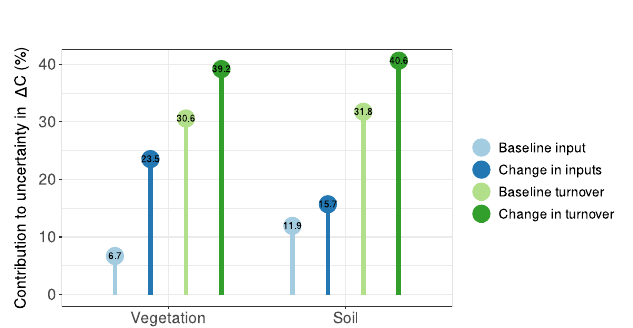
Fig. 5 | Attribution of uncertainty to processes in modelled changes in carbon stocks. The relative uncertainty (de fi ned as the standard deviation among model estimates) in the change in global vegetation ( Δ C v ) and soil ( Δ C s ) carbon stocks resultingfromeachofthedrivingterms(Eqs.9and10inMethods).Thefourterms are baseline input (baseline productivity NPP 1959 ) for vegetation and baseline lit- terfall/mortality ( f vs ,1959 ) for soil), change in inputs (change in productivity Δ NPP) for vegetation and change in litterfall/mortality ( Δ f vs ) for soil), baseline turnover ( τ v ,1959 forvegetationand τ s ,1959 forsoil),andchangeinturnover( Δτ v forvegetation and